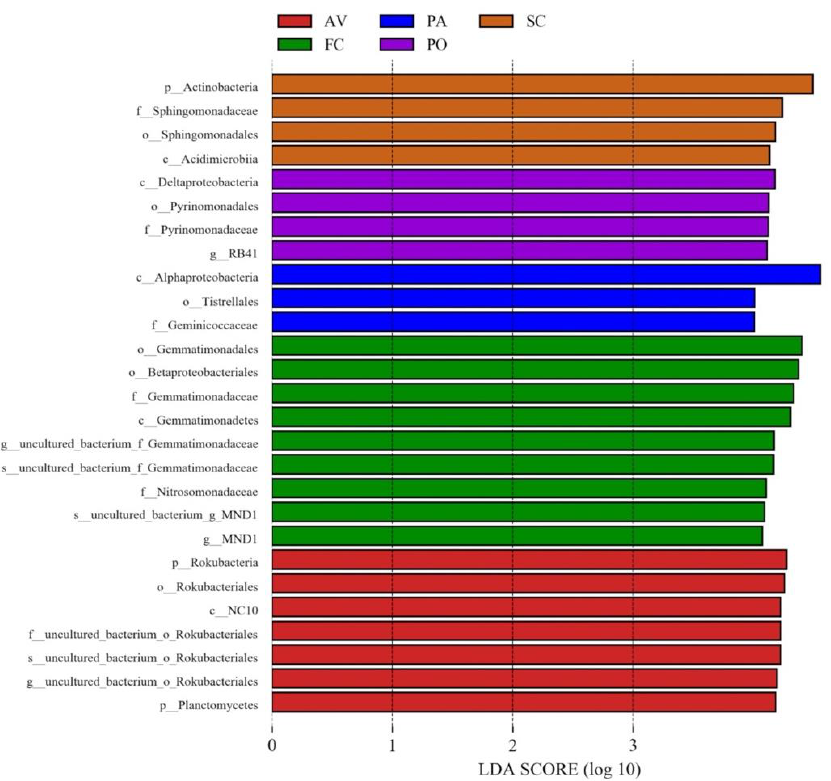
Figure 4. LEfSe analyses of rhizosphere bacterial taxa. The figure shows taxa whose LDA scores were greater than the set value of 4.0, and the length of the histogram represents the impact of different species.